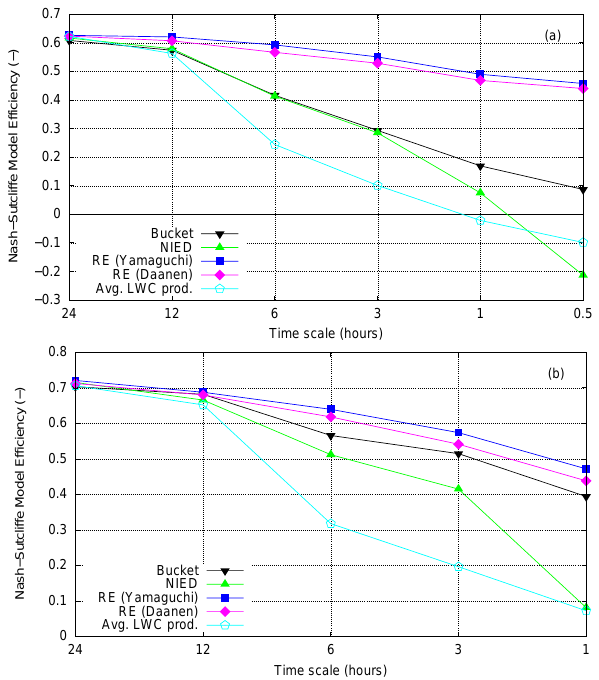
Fig. 6. NSE coefficients (model vs. measured) for the snow seasons for the 1h time scale for WFJ (a) and CDP (b) . the modelled density of the snowpack is too high, as sug- gested by the underestimation of snow height at CDP (see Ta- ble 1), hydraulic conductivity is estimated too low (Eq.